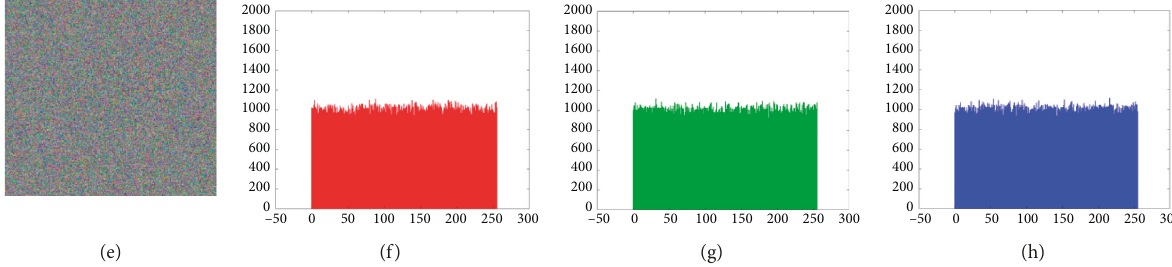
Figure 5: (a) Original image. (b–d) Histograms of the R, G, and B channels of the original image, respectively. (e) Encrypted image. (f–h) Histograms of the R, G, and B channels of the encrypted image, respectively.